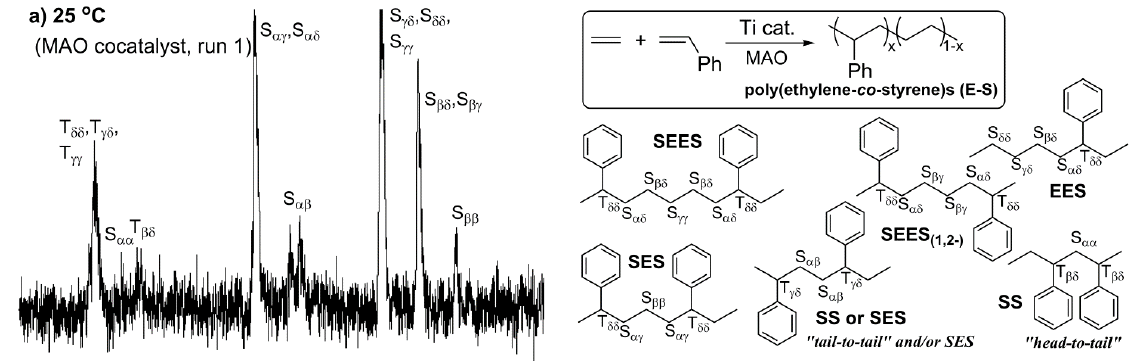
Figure 2. 13 C NMR spectra (in 1,1,2,2,-tetrachloroethane- d polymers (acetone insoluble fraction) prepared by Cp*TiCl catalyst system [55]. Conditions: 4 2.0 μ mol, ethylene 4 atm., styrene 10 mL, toluene 20 mL, 10 min., temperature at ( a ) 25 °C (run 1), ( b ) 40 °C (run 2), ( c ) 55 °C (run